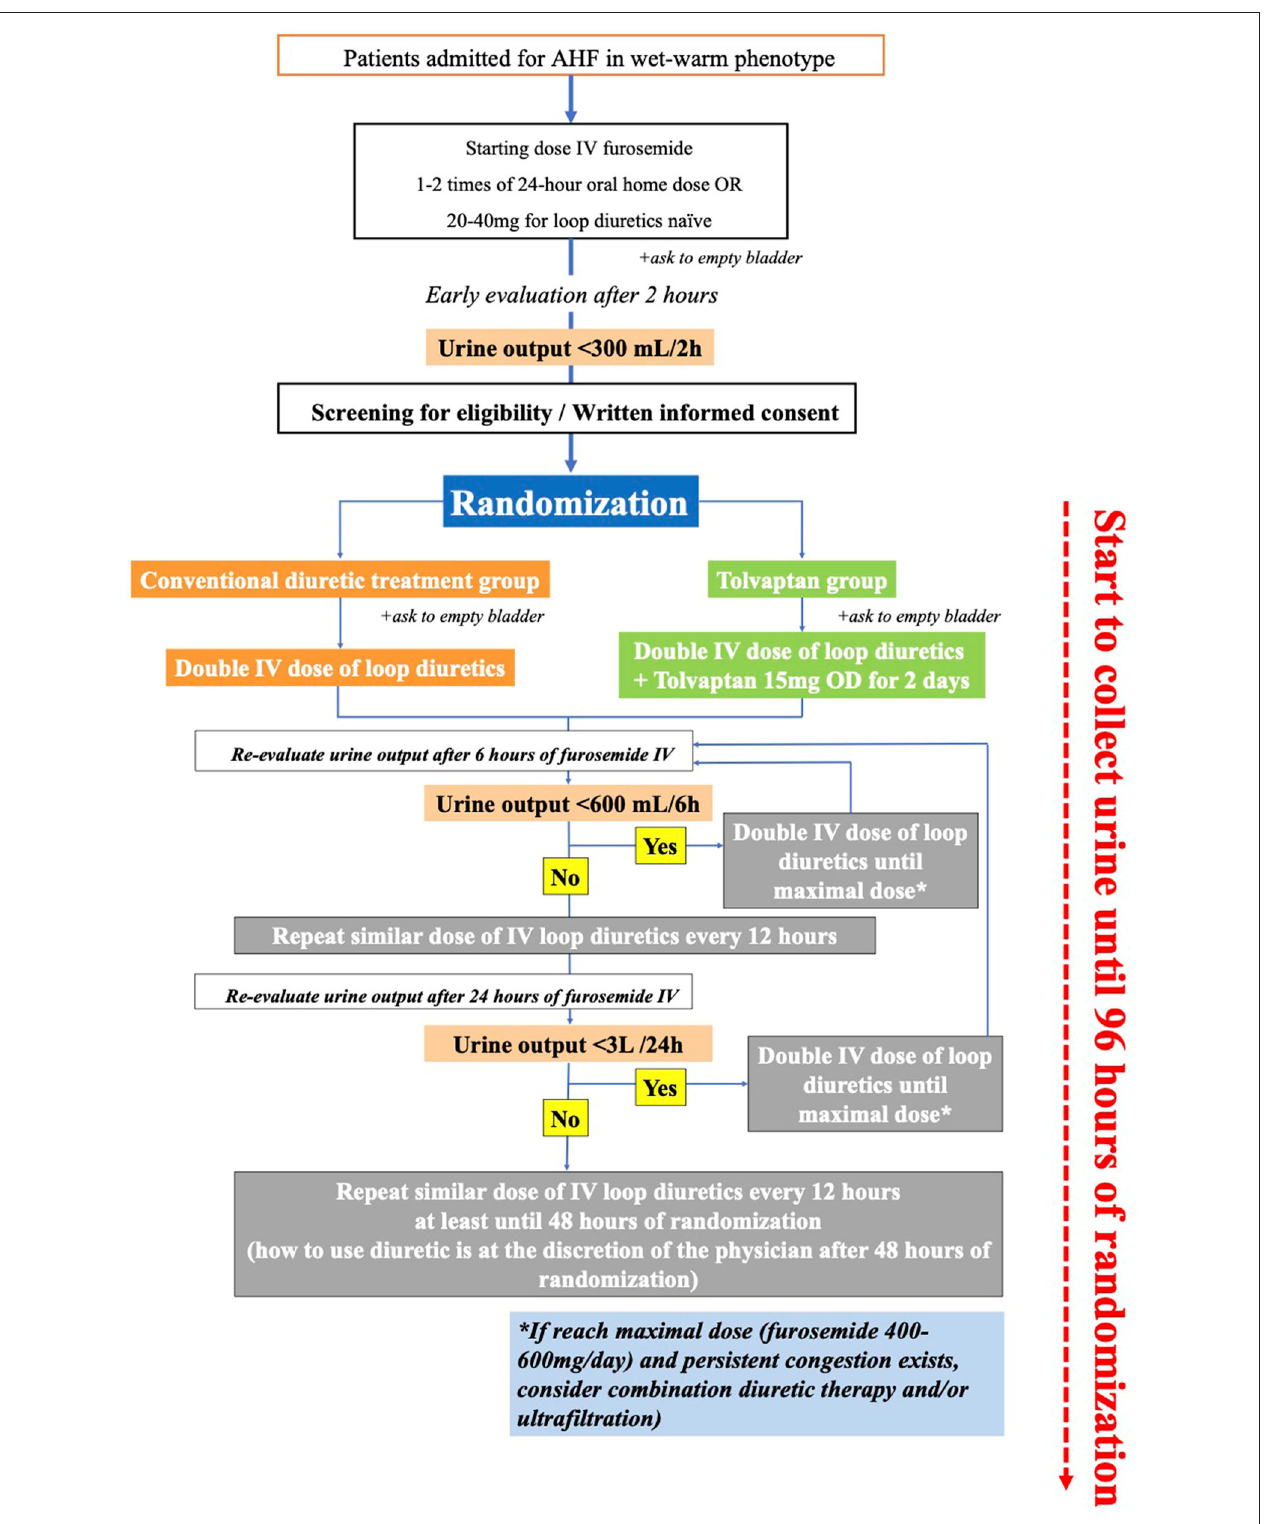
FIGURE 1 | Study protocol. At 24h, study participants will be evaluated by the same investigator (Hai H. N., Hoa K. T., Anh H. N., Thao T. N., or Tin T. H. ). If the investigator determines that the patient is absolutely hypovolemic and symptomatic, the study protocol will be ended.